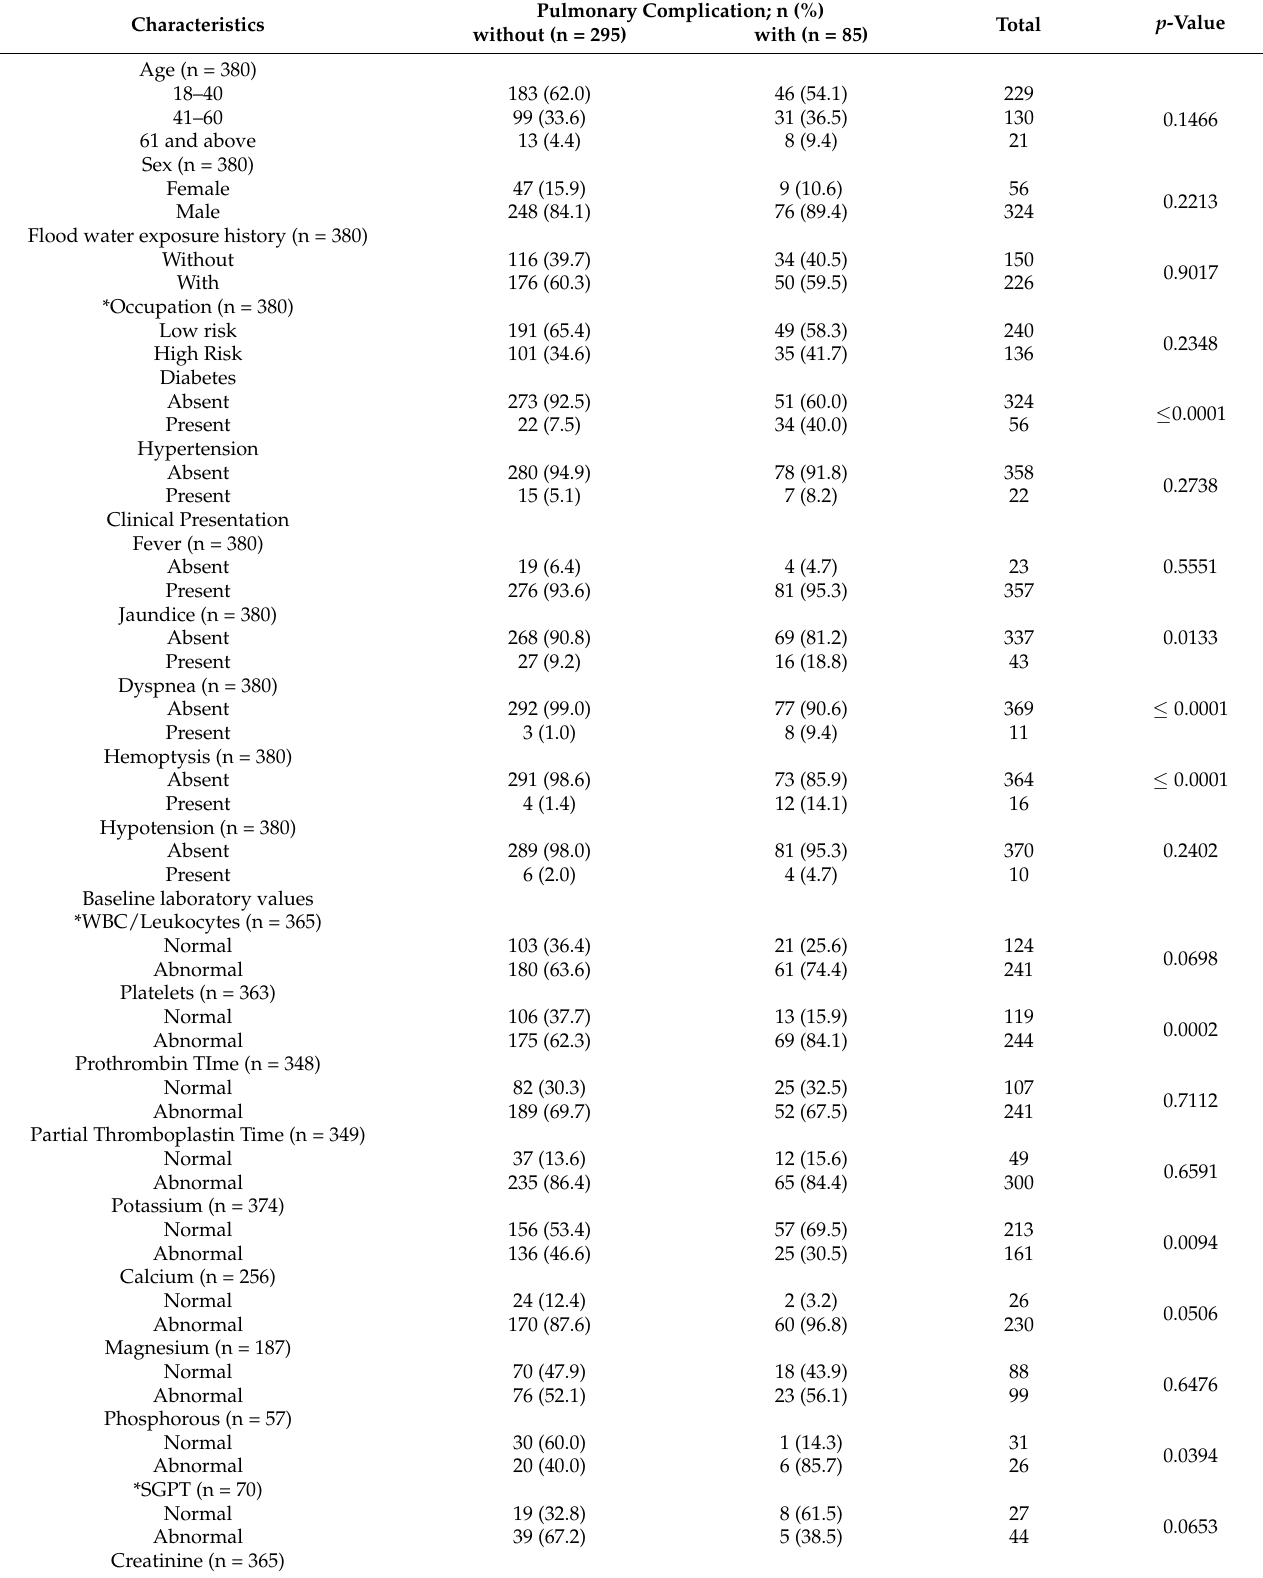
Table 1. Distribution of pulmonary complications according to baseline